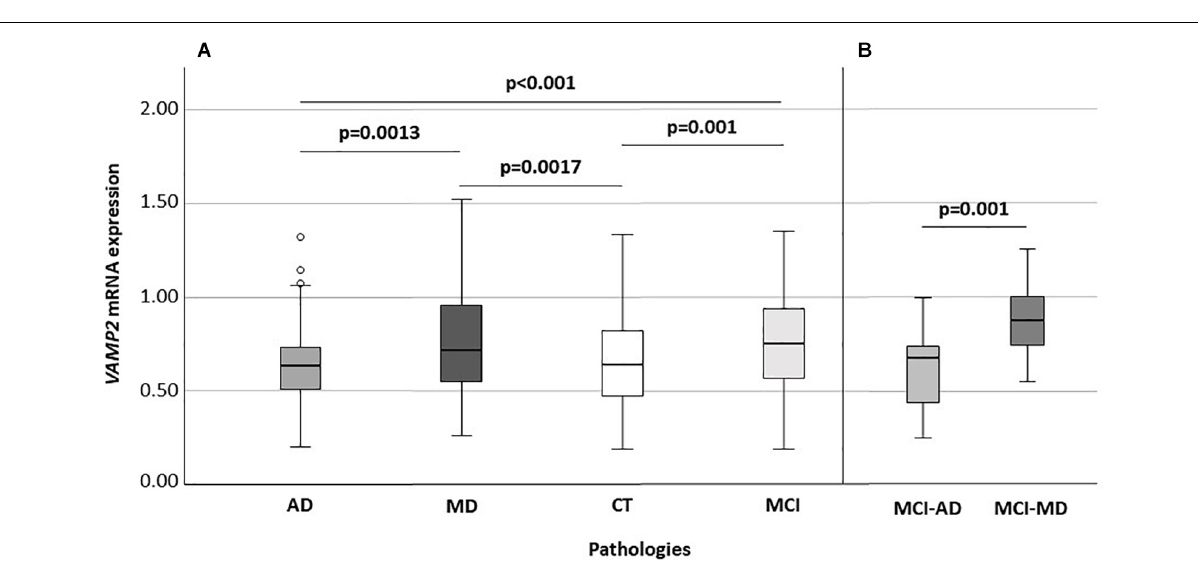
FIGURE 2 | VAMP2 expression according to diseases (A) and according to the MCI evolution (B) . Global significance: p < 0.001 (A) . AD, Alzheimer’s Disease; MD, mixed dementia; CT, subject without cognitive decline; MCI, Mild Cognitive Impairment; MCI-AD, MCI individuals evolved to AD; MCI-MD, MCI individuals evolved to mixed